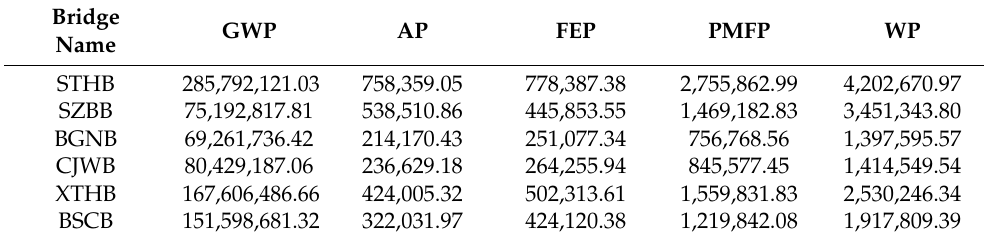
Table 6. Life cycle assessment (LCA) statistical tables for six cable-stayed bridges. Unit: kg.